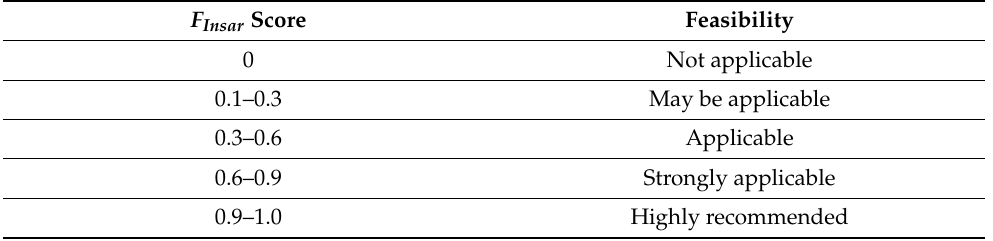
Table 9. The assessment rules of